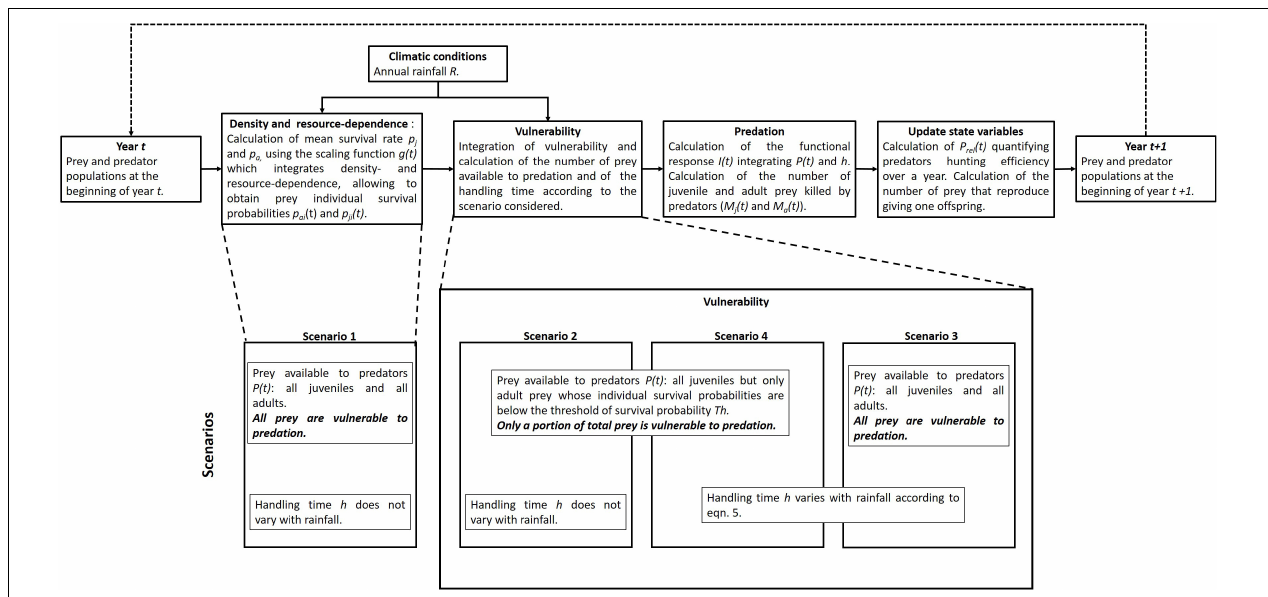
FIGURE 3 | Model summary with the key model steps. The dashed line arrow symbolises the next time step. As scenario 1 is independent from vulnerability sources, it is presented aside from the other scenarios. Conversely, details of the processes defining vulnerability related to either body condition or habitat characteristics are presented in scenarios